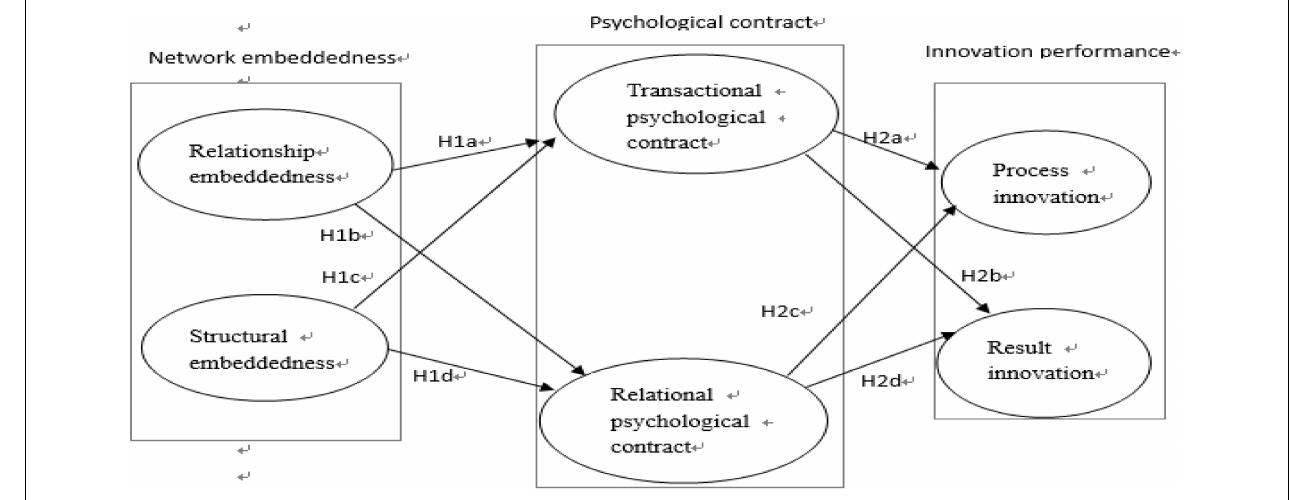
FIGURE 1 | Research model.